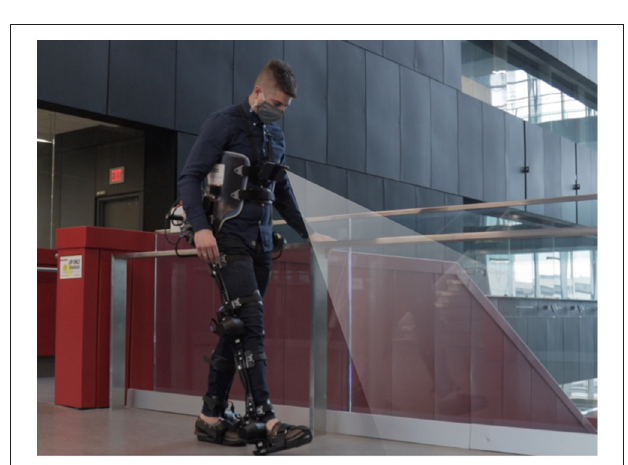
FIGURE 3 | Photograph of the lead author walking with our robotic exoskeleton with vision-based environment sensing superimposed.